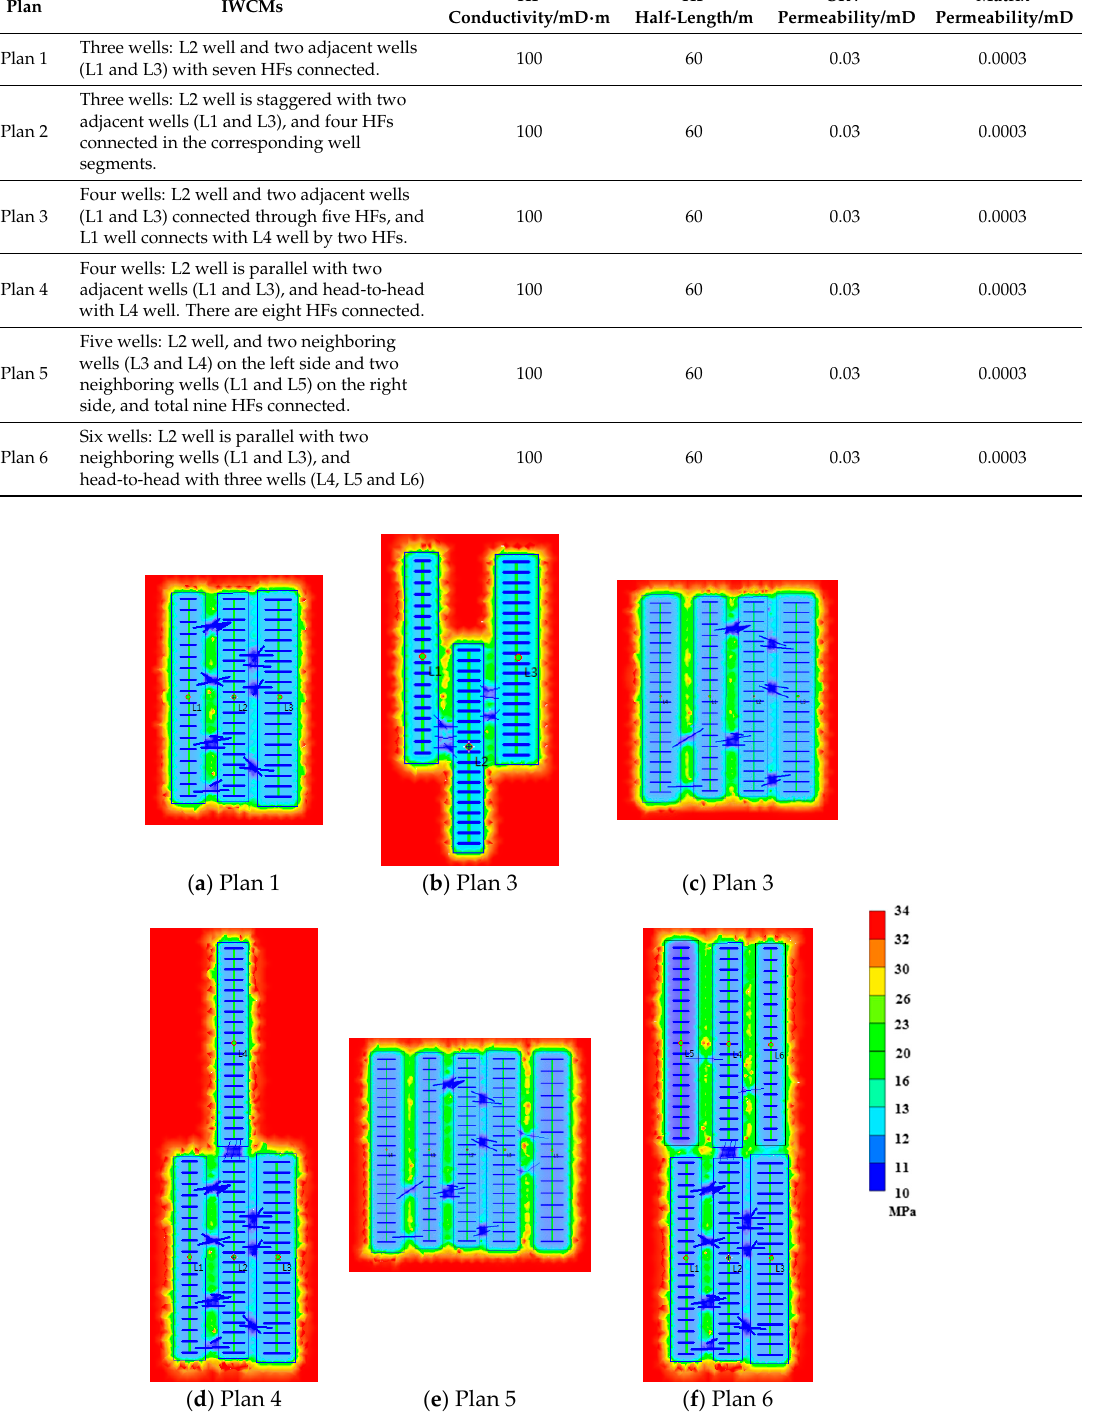
Figure 12. Pressure field under different well pattern and multiple neighboring wells in six designed plans.